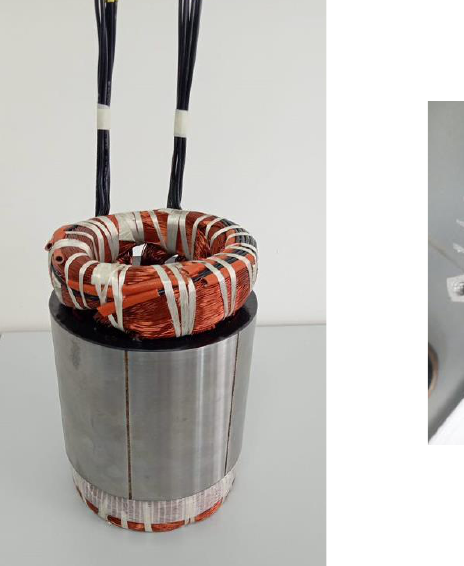
Figure 2. Windings of SRMs: ( a ) the proposed segmental SRM; ( b ) the conventional SRM.